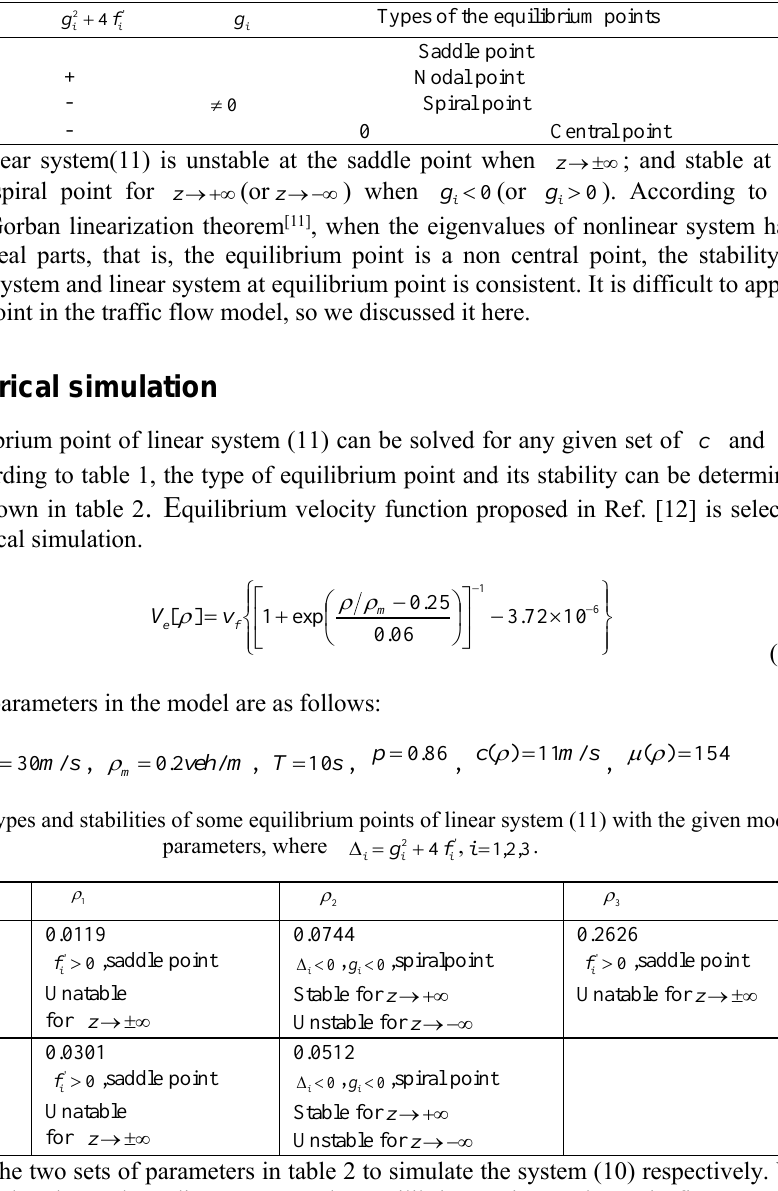
Table 1. Types of equilibrium points for linear dynamical systems (11).